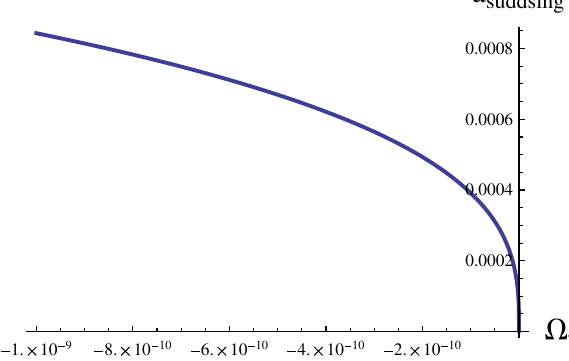
Fig. 12 Diagram of the relation between a sing and negative (cid:3) γ . Note that in the limit (cid:3) γ (cid:7)→ 0 the singularity overlaps with a big-bang